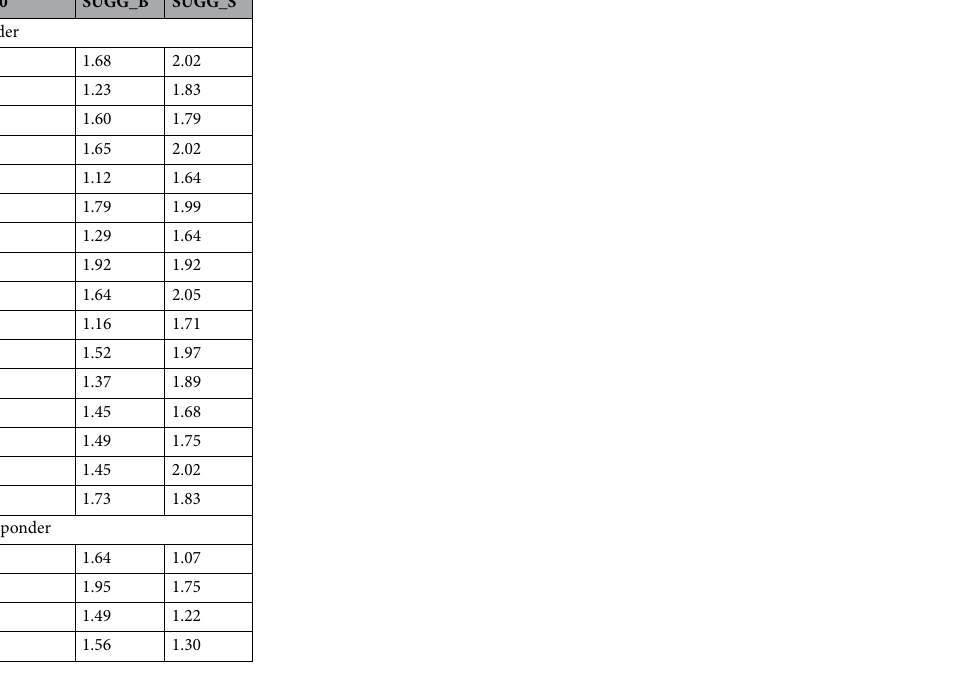
Table 1. Discrimination thresholds (mm) of all participants for three hypnotic